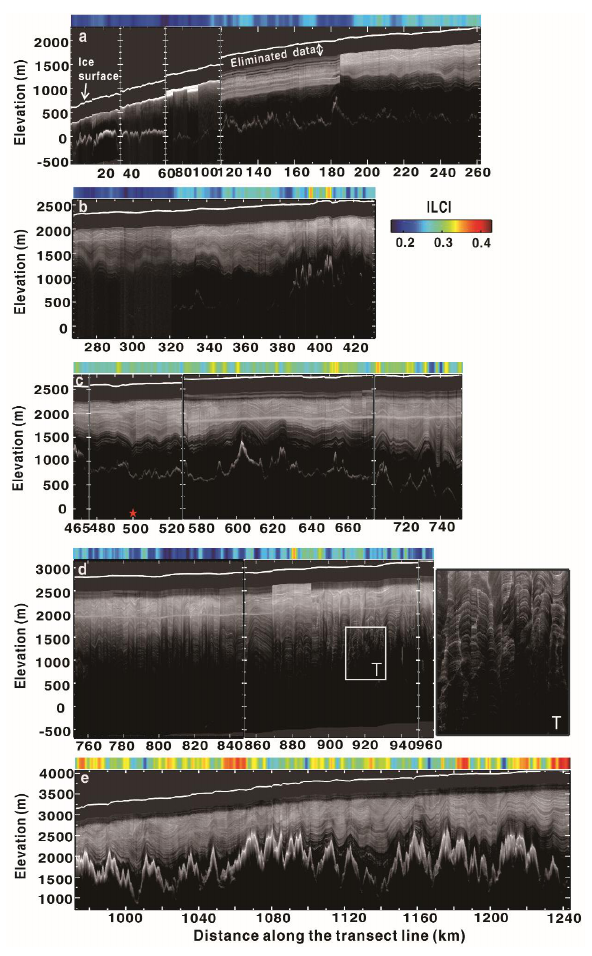
Figure 2. Radar profiles and internal layer continuous index (ILCI) plot of the Zhongshan to Dome A. (a-e) respectively represent the regions of Zone A, Zone B, Zone C, Zone D, and Zone E (See Figure 3). ILCI is the result of average from the 500-trace window. The red star marks the location of Taishan Station. The profile in T is the position of the white rectangle in figure 3d. The white line in the radar profile indicates the surface, and the ice thickness of about 340 m (2000 sampling points) in the middle is the eliminated data.